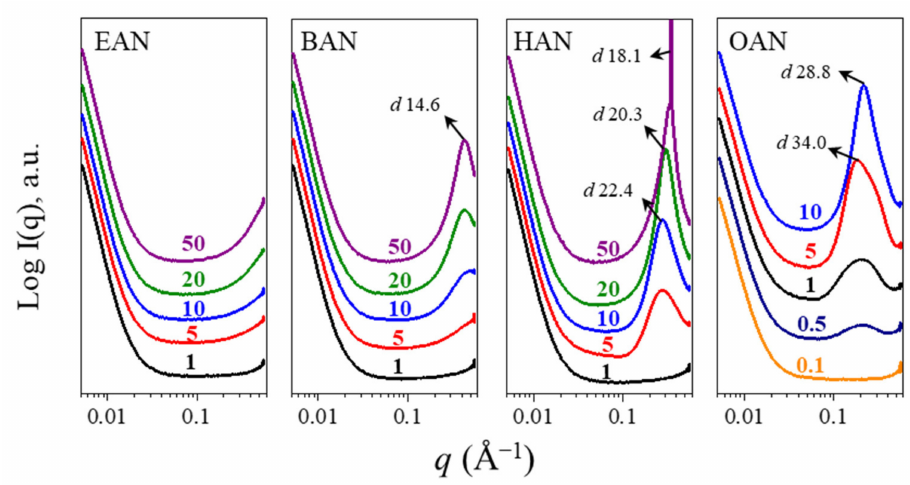
Figure 3. The SAXS profiles of EAN, BAN, HAN, and OAN-water mixtures with correlation distances ( d ), indicated by the arrows. The color numbers on the plots refer to the PIL concentration in